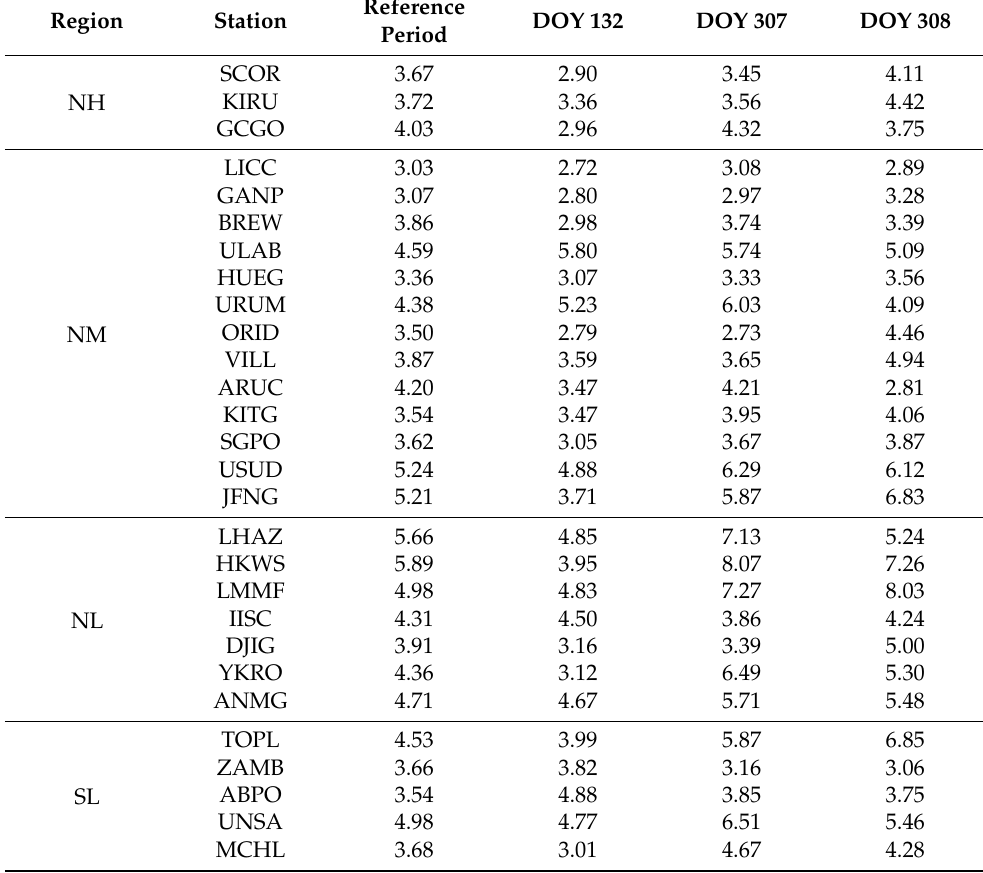
Table 4. 3D positioning accuracy during the reference periods and strong geomagnetic storms for GPS + GPSK8 (unit: m). N stands for Northern Hemisphere, S for Southern Hemisphere, H for High Latitude (60~75 ◦ ), M for Mid Latitude (30~60 ◦ ), and L for Low Latitude (0~30 ◦ ).